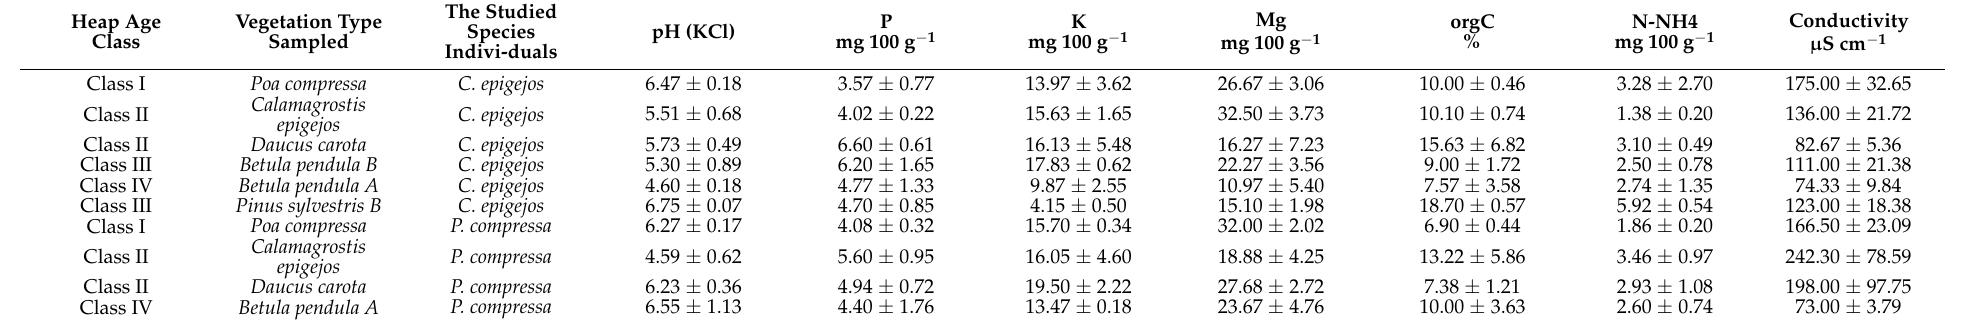
Table 2. Physico-chemical properties of the substrate from the rhizosphere zone of the target species growing in the studied vegetation patches on coal mine